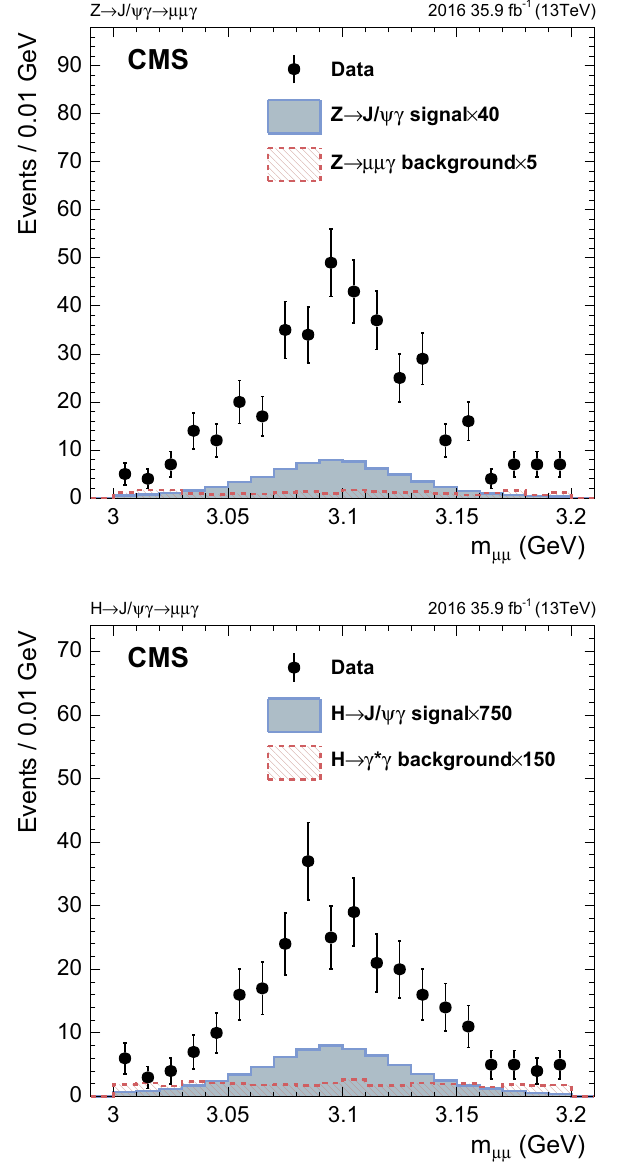
Fig. 4 The m μμ distributions in the Z (upper) and Higgs (lower) boson searches. The number of events in the distributions from signal events is set to respective factors of 40 and 750 larger than the SM values for the predicted yields for Z and H boson decays. The number of events in distributions in the resonant background samples is normalized to 5 and 150 multiples in the expected yields